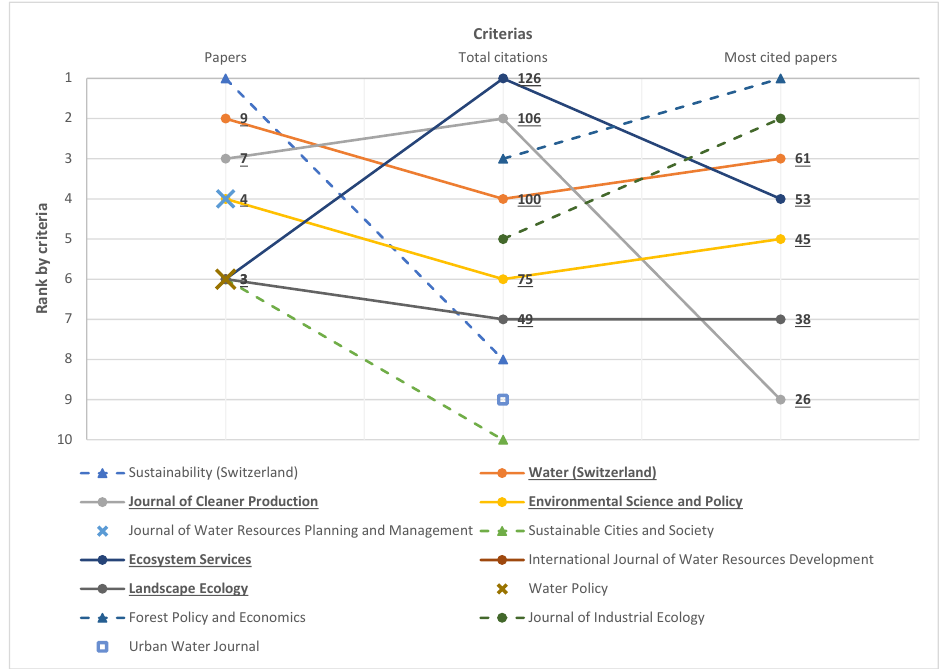
Figure 6. Ranking of the selected sample according to the number of documents, citations, and most cited articles.